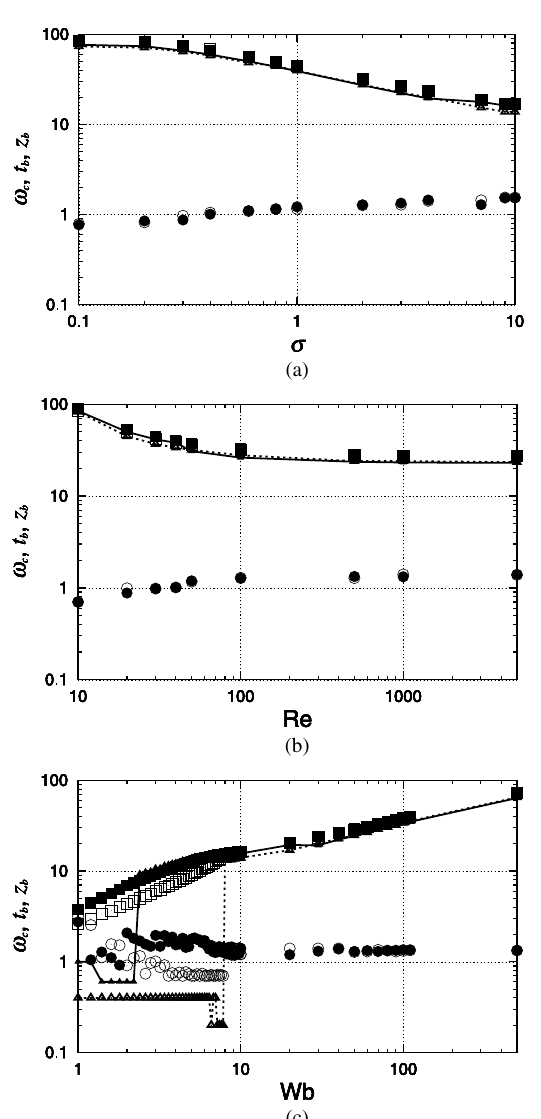
Fig. 3 Variations of the critical frequency ω c , breakup time t b and breakup distance z b when σ varies in (a), Re in (b) and Wb in (c), where ω c is denoted by (cid:5) , z (cid:2) + - - - and (cid:3) + —– and t (cid:4) and (cid:5) , for all of which the open and b by b by closed symbols, respectively, represent the cases for φ = 0 and π